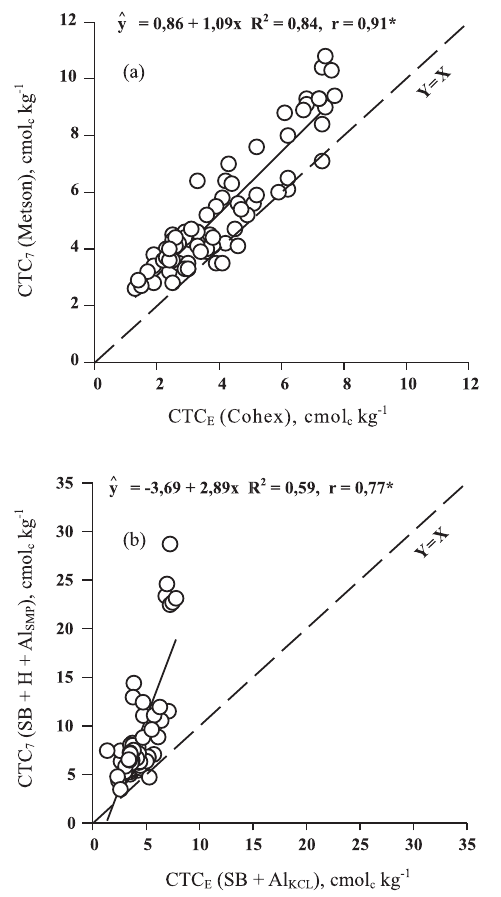
Figura 3. Relação entre CTC diferentes métodos de estimação a) segundo Afnor (1996) e b) segundo CQFSRS/SC (2004).